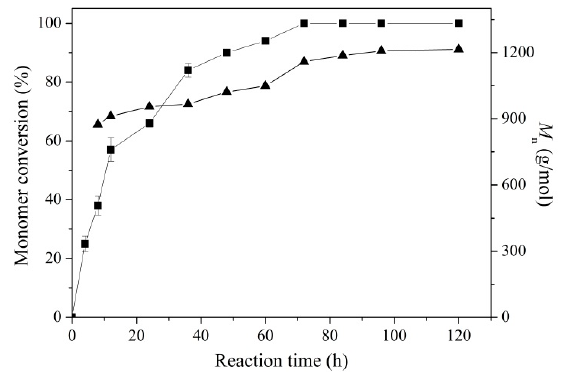
Figure 4. Monomer conversion ( ▲ ) and M n ( ■ ) as a function of reaction time. The reactions were carried out using 80 mg EC-EP-AFEST, 200 μ L ε -caprolactone and 600 μ L toluene at 80 °C for different reaction times.